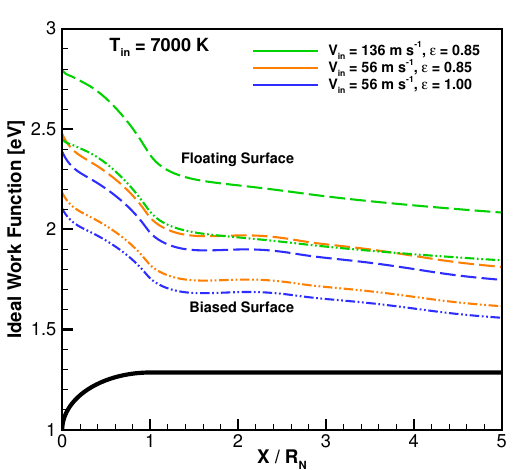
Figure 13. Wall temperature and plasma density along the wall for two levels of surface emissivity, (cid:101) , and inlet velocity